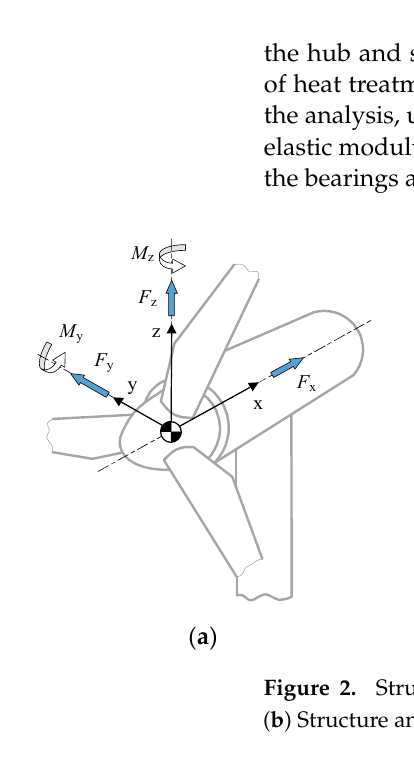
Figure 1. Design of logarithmic crowned roller for wind turbine spindle bearing.